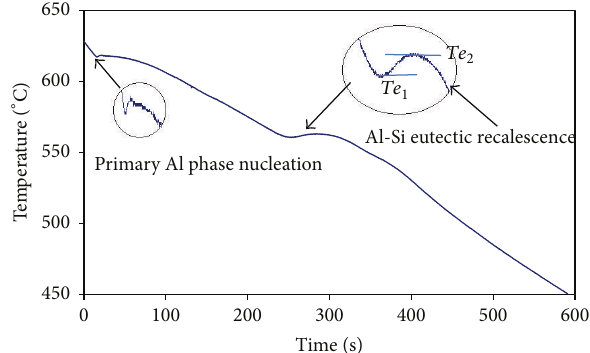
Figure 2: Al-Si eutectic recalescence in a binary Al-7% Si alloy, Te 1 = 𝑇 M temperature, and Te 2 = 𝑇 G temperature